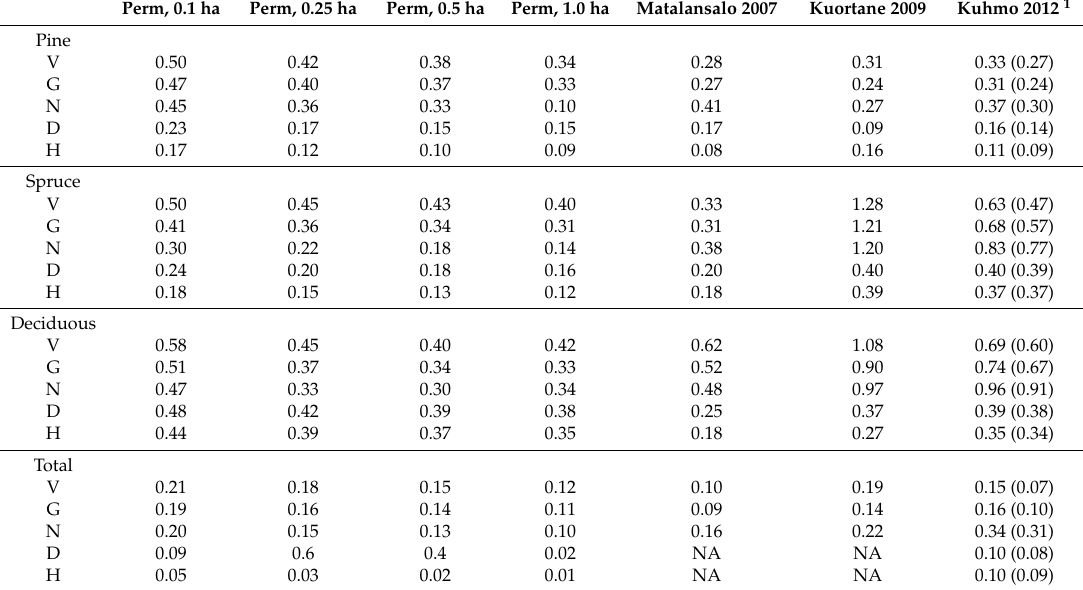
Table 5. Stand level RMSE values relative to the mean in the Perm and Finnish studies. In Perm, the results are presented for four different levels of aggregation.